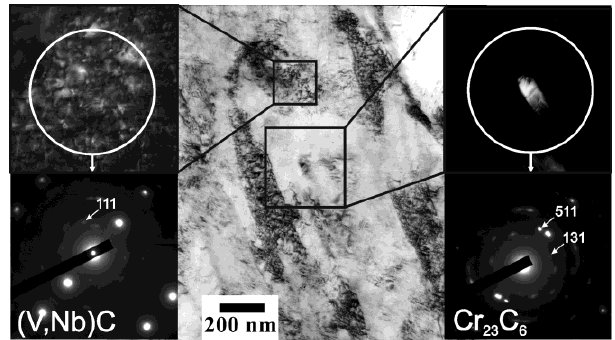
Figure 2. Dispersed carbides in an HSLA steel subjected to tempforming at 873 K.